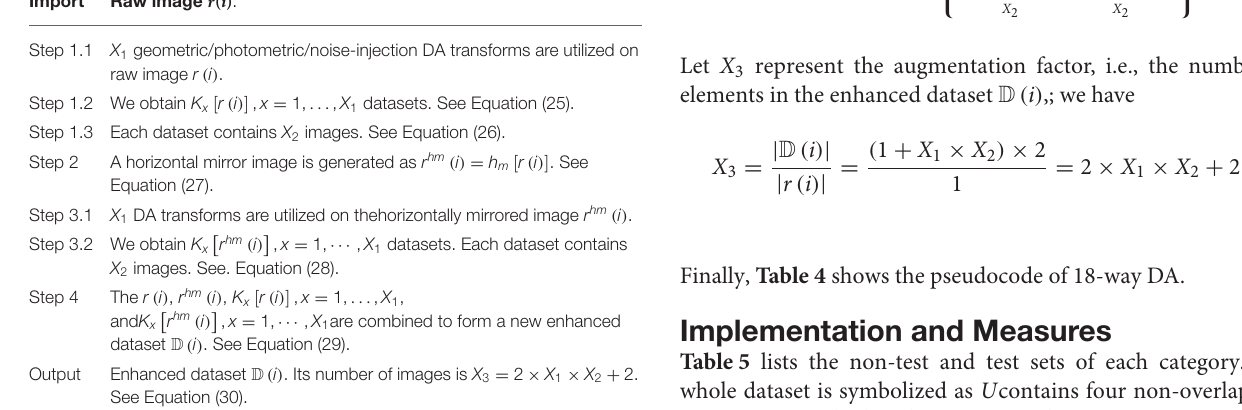
Table 5 lists the non-test and test sets of each category. The